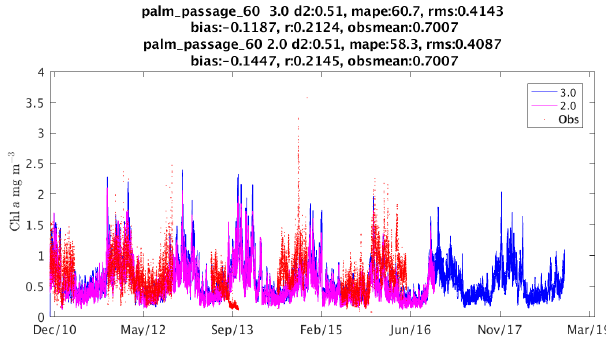
Figure 16. Observed chlorophyll fluorescence (red dots) at 60m depth at the Palm Passage site with a comparison to configurations vB3p0 (blue) and vB2p0